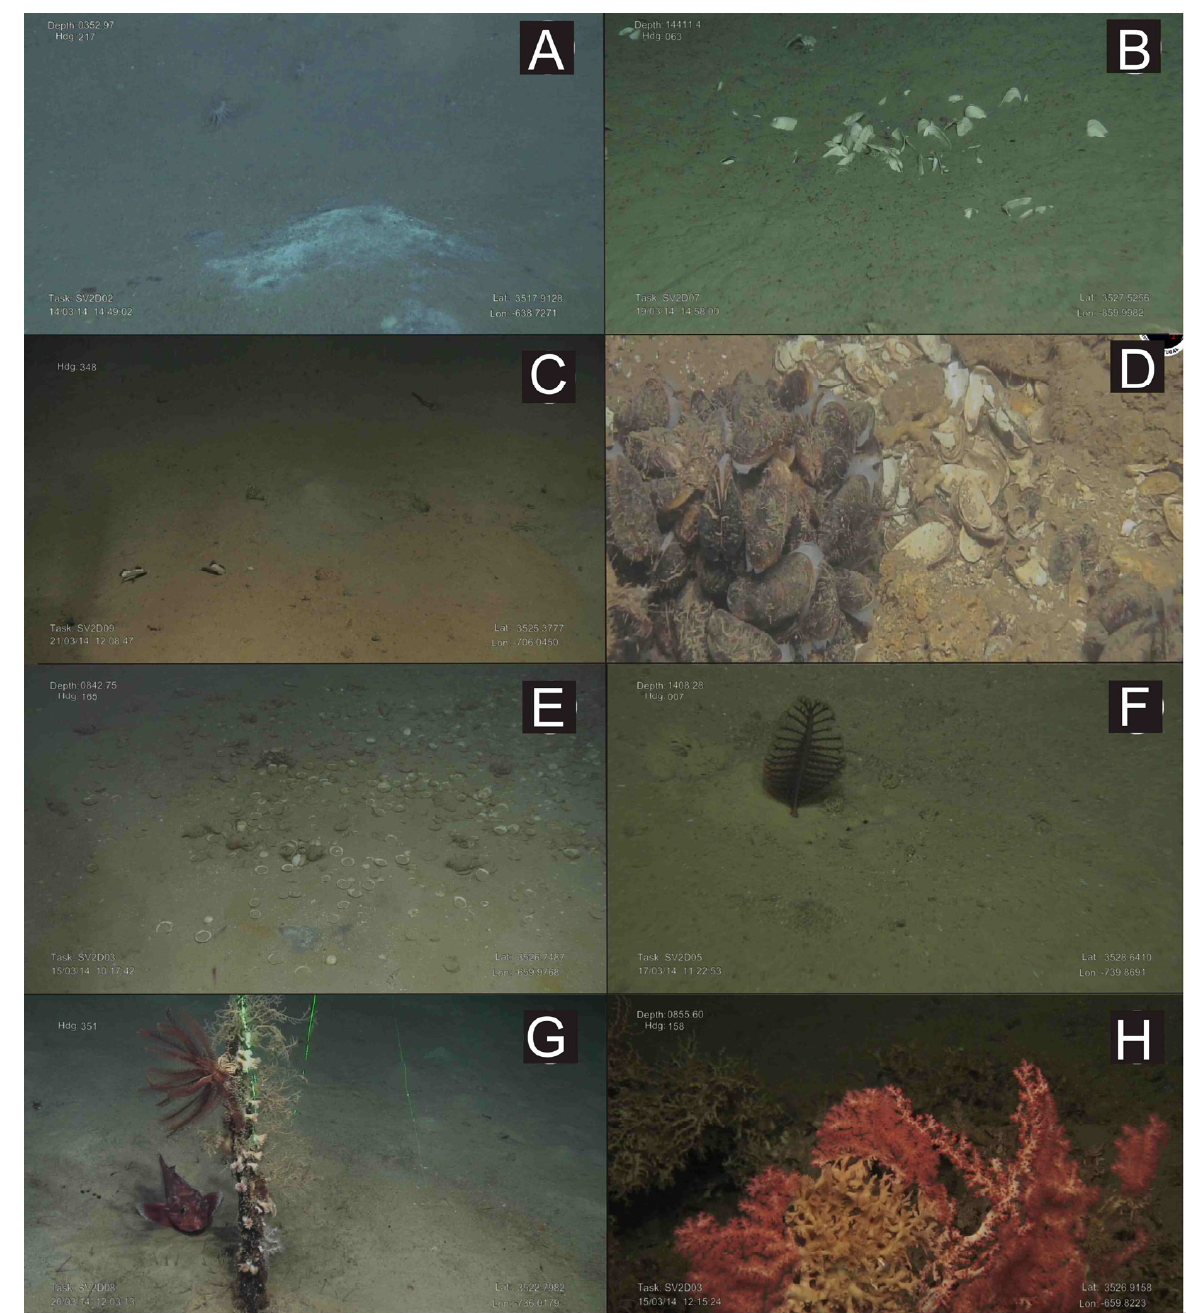
Figure 6. Underwater images obtained with the ROV “Luso”during the SUBVENT-2 expedition in mud volcanoes (MVs) of the Moroccan margin. ( A ): Beggiatoa -like bacterial mats and two cerianthids at the summit of the Mercator MV; ( B ): Accumulation of shells of the chemosymbiotic bivalve Isorropodon megadesmus on muddy substrates at the summit of the Bonjardim MV; ( C ): Shells of the chemosymbiotic bivalve Acharax gadirae at the summit of the Yuma MV; ( D ): Beds of the living chemosymbiotic Bathymodiolus mauritanicus in the Algacel MV; ( E ): Extensive graveyards of the chemosymbiotic bivalve Lucinoma asapheus at the Northern Pompeia Coral Ridge (Pompeia Coral Mound Province); ( F ): Sea-pen ( Pennatula sp.) on muddy sediments at the Las Negras MV; ( G ): An iron bar of anthropogenic origin colonized by small gorgonians, solitary corals ( Desmophyllum dianthus ) and crinoids at the Yuma MV; ( H ): Living scleractinians( D. pertusum ) and stony octocorals ( Corallium ) colonizing dead scleractinian skeletons in the Pompeia Coral Mound Province.